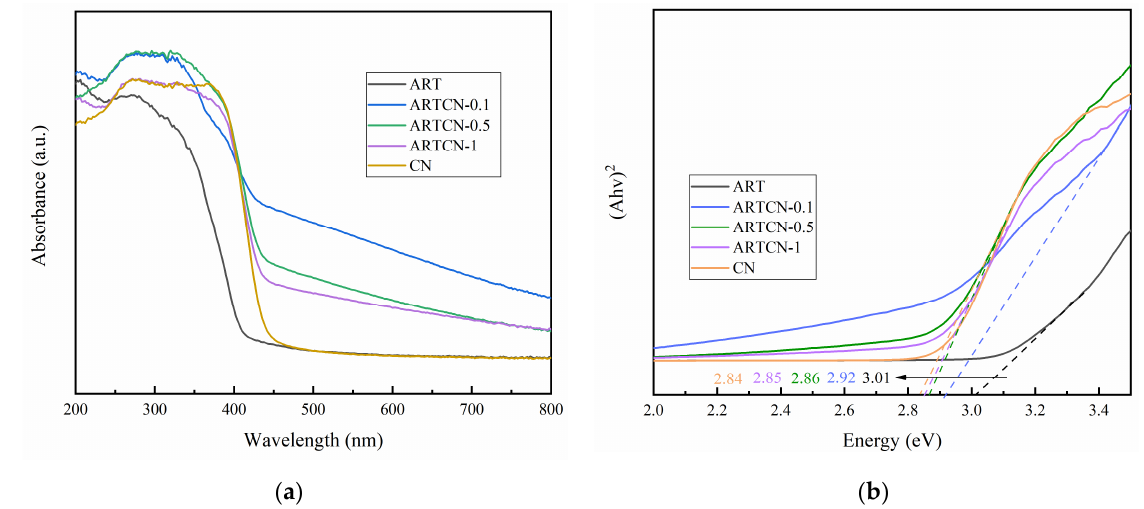
Figure 5. Optical properties ( a ) and the band gap width ( b ) of the samples.